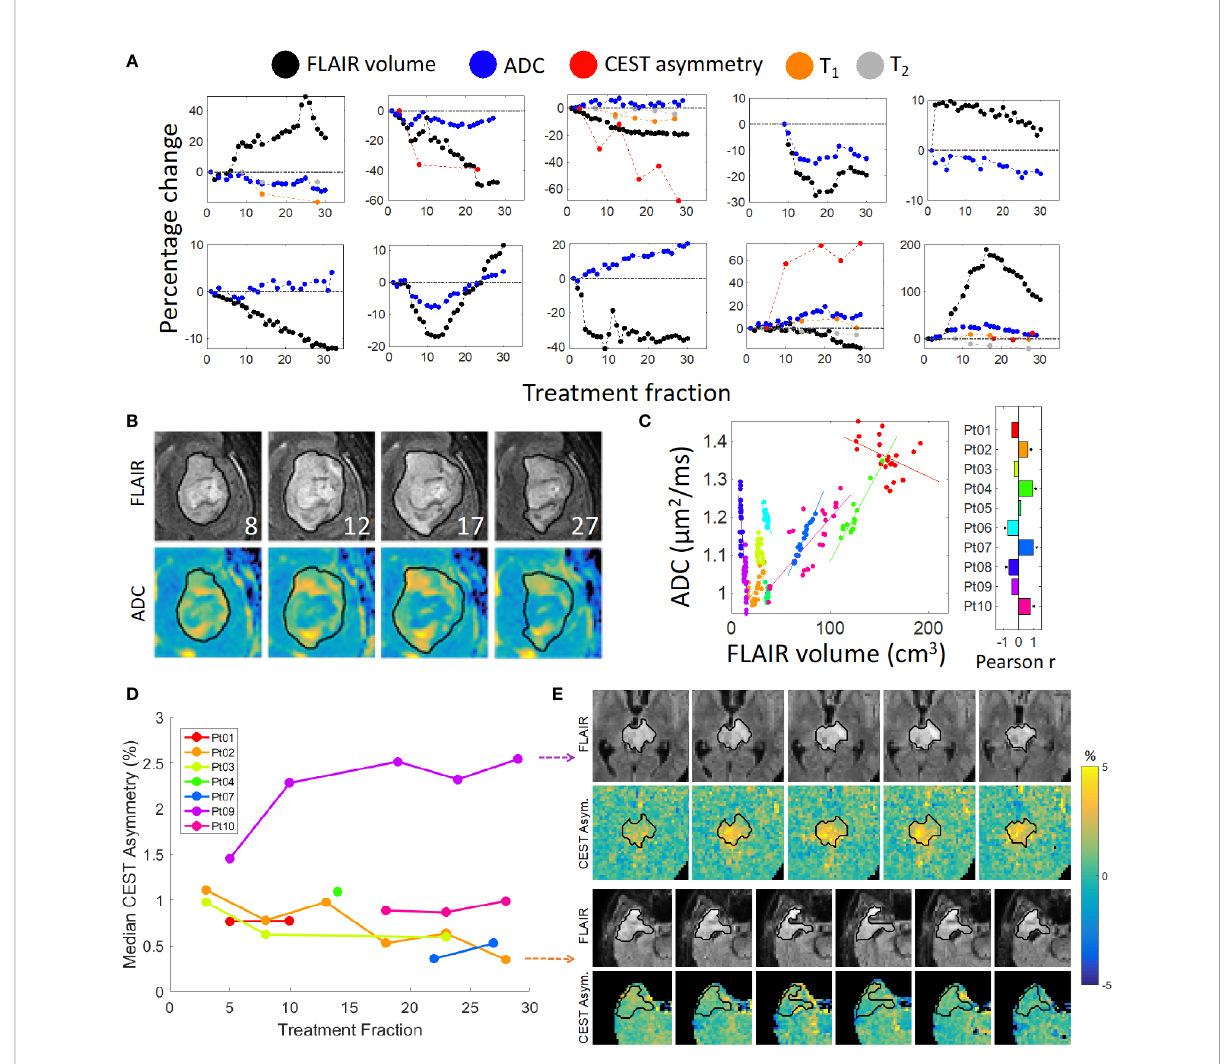
FIGURE 3 Quantitative imaging and FLAIR contours: (A) FLAIR volume and median functional parameter values plotted over time. Zoomed images are shown in (B) of the ADC maps for Patient 10 with corresponding FLAIR images with overlaid daily FLAIR contours (in black); the treatment fraction is shown in the lower-right corner of each FLAIR image. A plot of the ADC values vs FLAIR volumes is shown in (C) , where each color represents a different patient. The correlation coef fi cients are shown in the bar plot; an asterisk indicates a statistically signi fi cant correlation. (D) Median CEST asymmetry with respect to treatment fraction computed over a single slice for the time points with available CEST imaging. Zoomed images are shown for Patient 2 (bottom panel) and Patient 9 (top panel) over time in (E) exhibiting decreasing and increasing asymmetry,